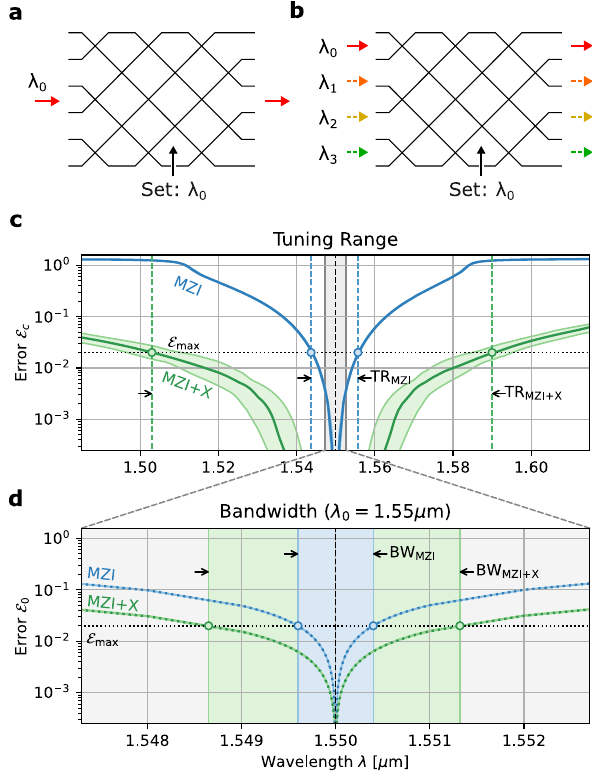
Fig.7|TuningrangeandbandwidthforMZI+XandstandardMZImesh, N =64. a , b Contrastbetweensingle-andmulti-wavelengthoperation,whicharelimitedby tuningrangeandbandwidth,respectively. c Plotof E c ð λ Þ ,whichdictatesthetuning range for a target matrix error E max . d Corresponding plot of E 0 ð λ Þ , which dictates the bandwidth. Platform: 500×220nm Si:SiO 2 directional coupler with 200nm gap, d μ / d λ ≈ 3.27/ μ